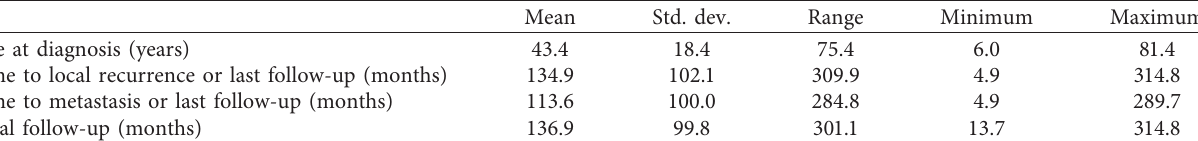
Table 1: Subject demographics and clinical survival information.